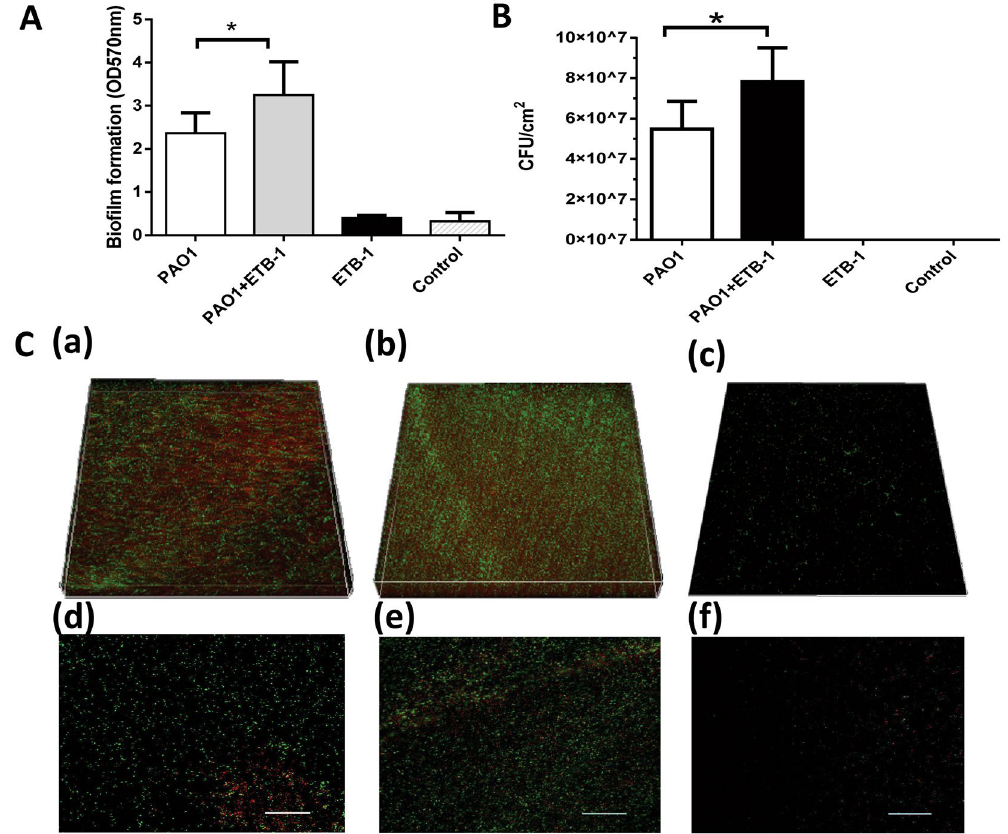
Figure 5. Biofilm formation assessed by crystal violet assay ( A ), plate count ( B ) and confocal laser scanning microscopy (CLSM) ( × 400) ( C ). PAO1 represents the 3-day Pseudomonas aeruginosa PAO1 biofilm. PAO1 + ETB-1 represents the 3-day Pseudomonas aeruginosa PAO1 and the clinical S . sanguinis strain